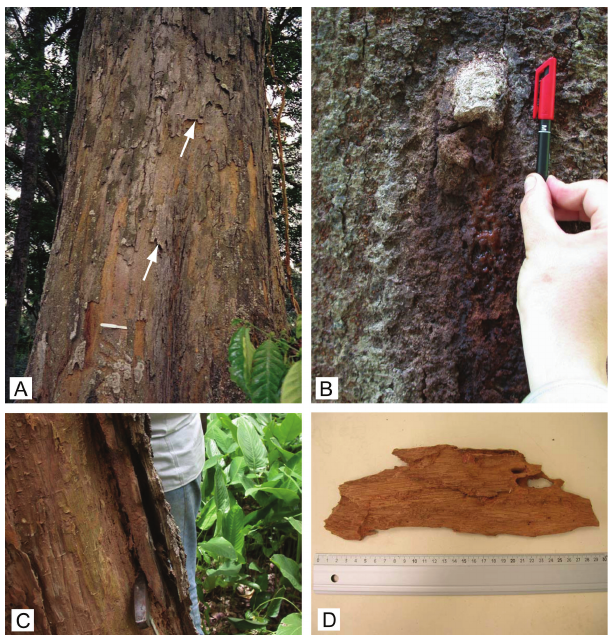
Fig. 1. (a) An iroko trunk showing abundant bark “flakes” (white arrows) on its trunk (site of Mambicham, Cameroon). This is typ- ical for mature trees. (b) Carbonate associated with sap exudation observed at the Kani site (Ivory Coast). Unidentified live insects have been observed in the liquid secretion after removal of the hard- ened secretion. (c) Xylem tissues exposed to the atmosphere due to termite activity (Kani site). (d) Wood slab partially reacting to hy- drochloric acid found on the ground inside a hollow trunk at the Biga site.